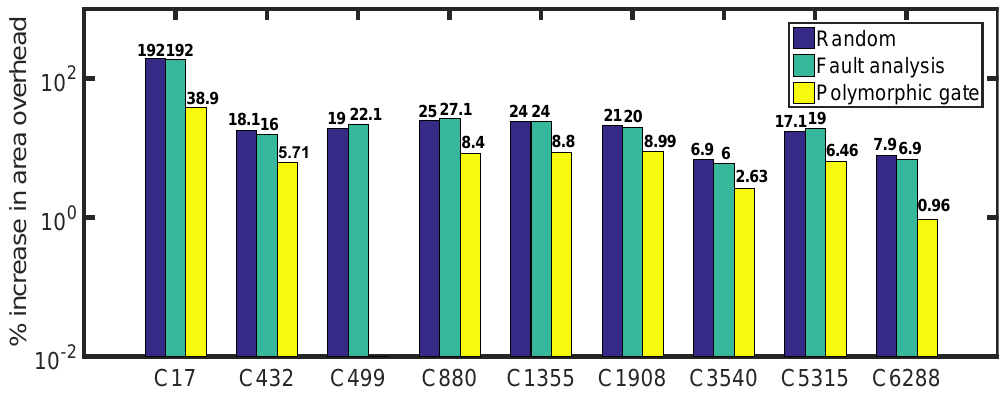
Figure 7. Area overhead of random, fault analysis and polymorphic gate based logic locking.